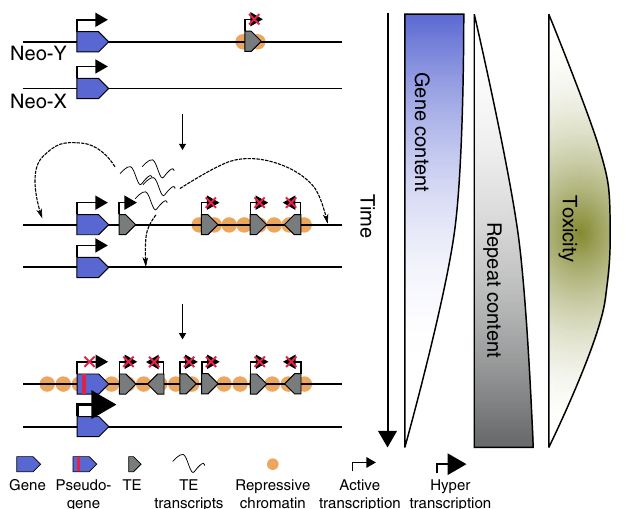
Fig. 6 Toxic Y chromosome and adaptive Y degeneration. Epigenetic con fl icts between host-speci fi c genes (blue) and sel fi sh genetic elements (gray) are maximized on Y chromosomes of intermediate age (maximum toxicity). Active transcription of Y-linked genes impedes heterochromatin formation at repeats that accumulate on degenerating Y chromosomes and their mobilization can create a mutational burden in males (middle). Selective pressure to ef fi ciently silence a toxic Y chromosome and dosage compensation of the X homologs could drive adaptive degeneration of Y